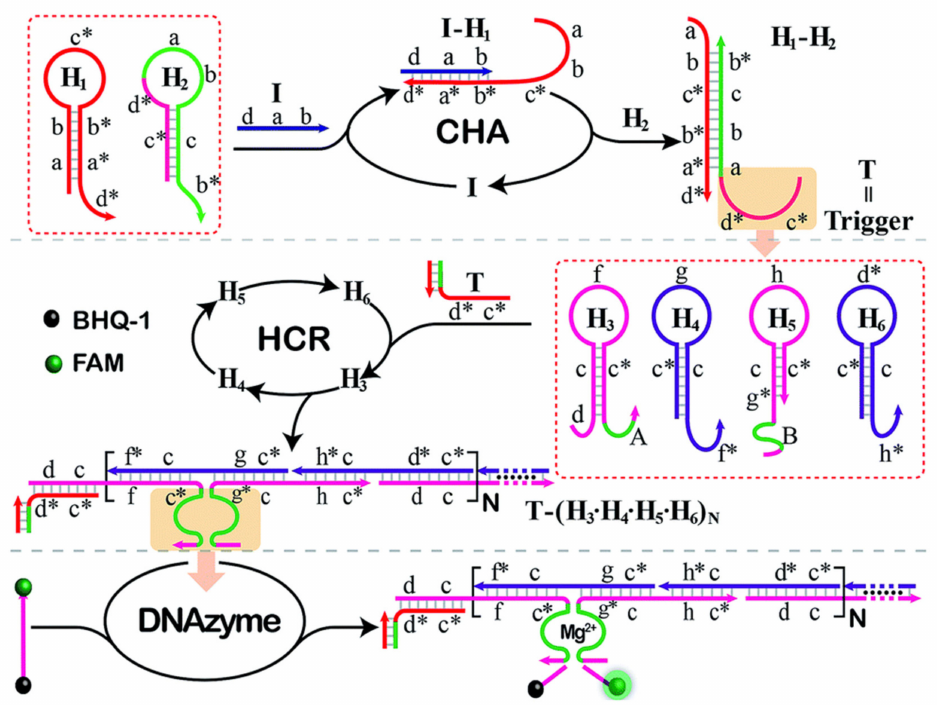
Figure 2. Schematic diagram showing an example of cascade amplification strategy involving catalyzed hairpin assembly (CHA) and hybridization chain reaction (HCR) where both strategies also employ hairpin probes for signal amplification. Reprinted from [46] with permission from Royal Society of